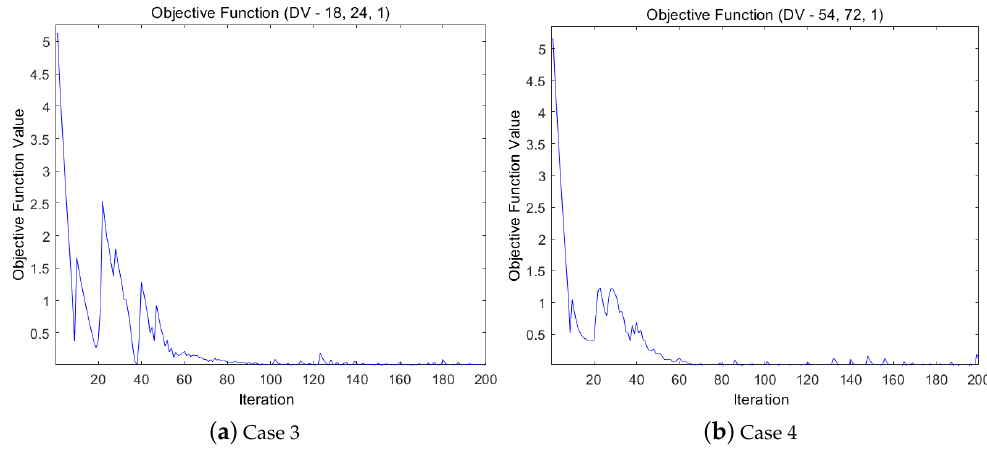
Figure 9. Objective function convergence for Cases 3 and 4.